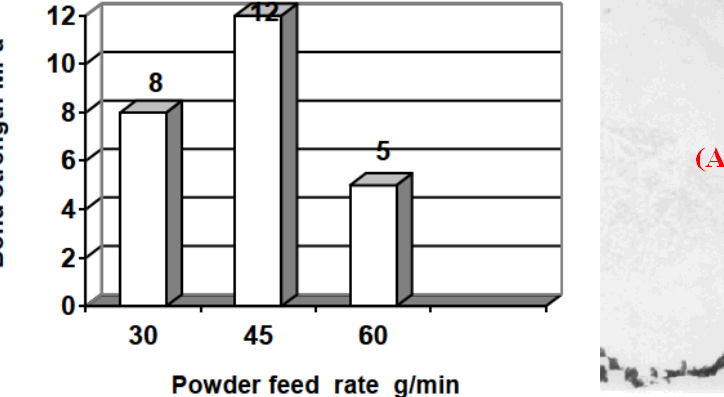
Figure 3: Al-12Si layers’ bond strength